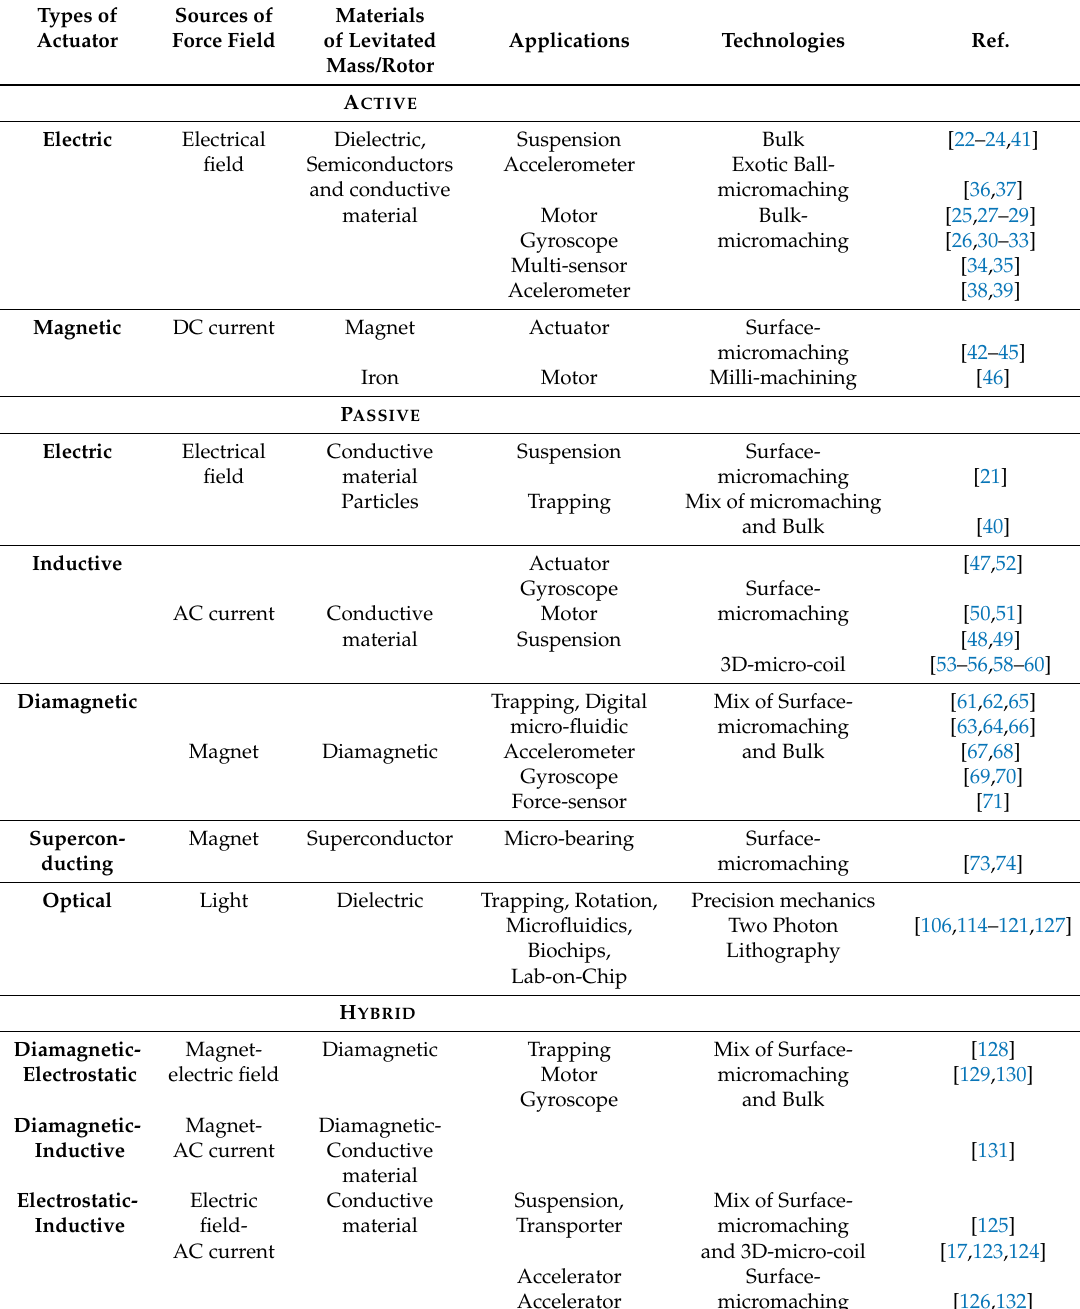
Table 1. Levitating